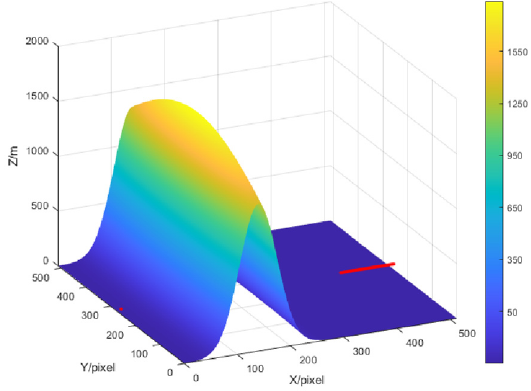
Figure 3. Generated topographic map diagram.